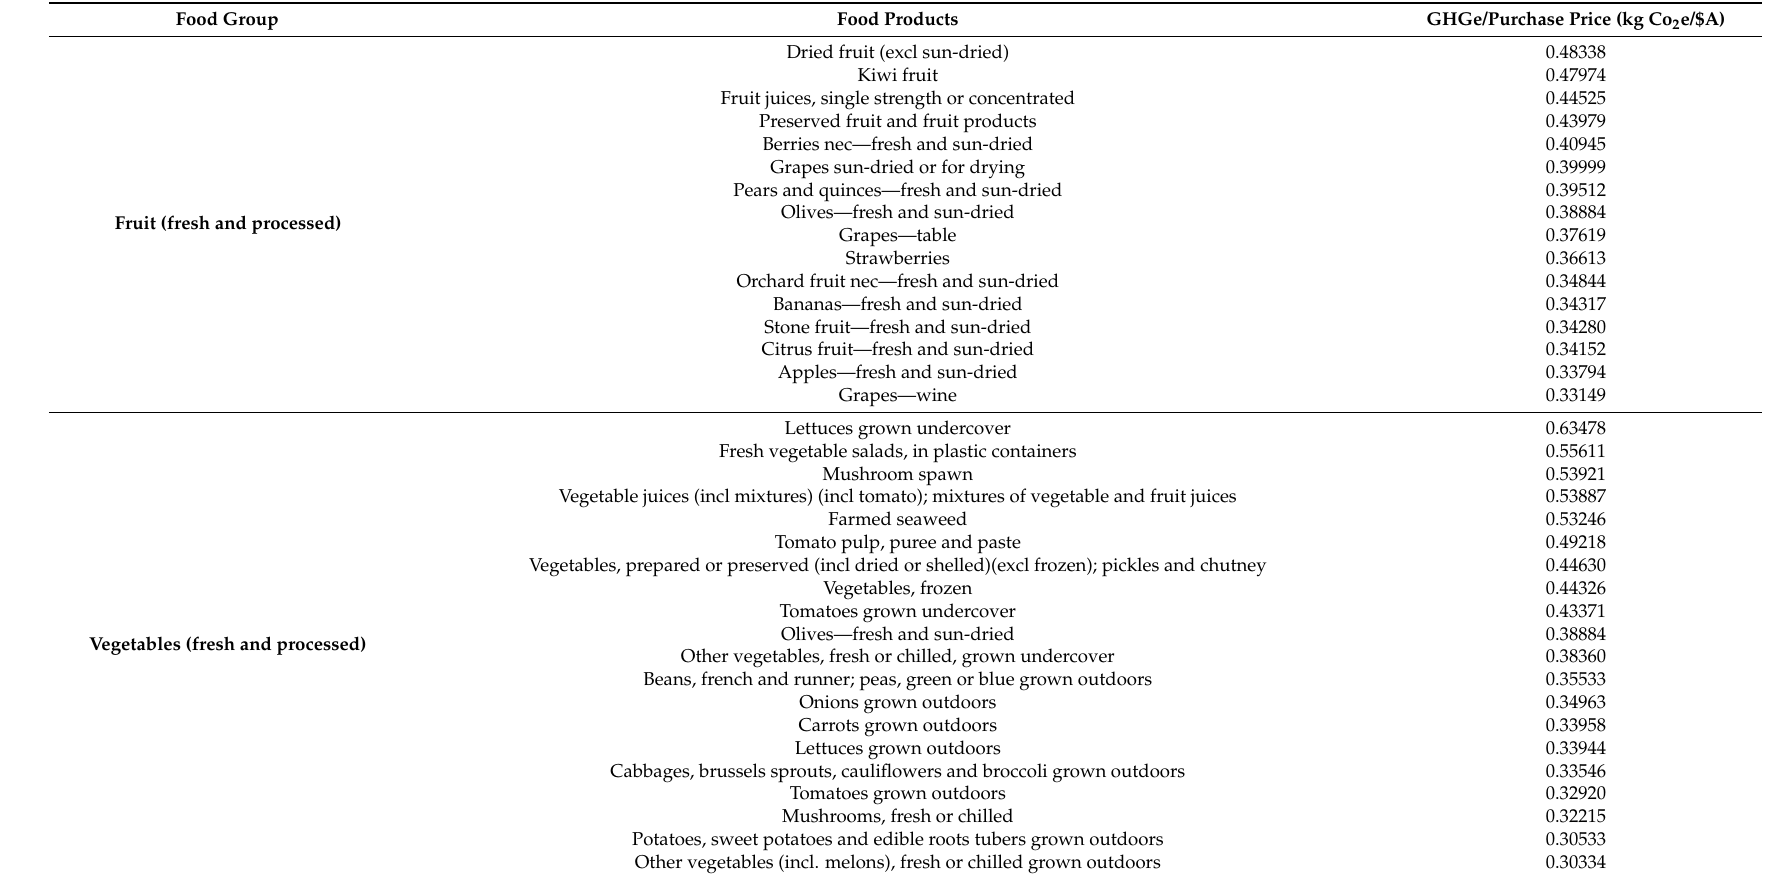
Table A1. Greenhouse gas emissions per purchase price (kg CO 2 eper Australian dollar (($A) for all food products used in this analysis, categorized into their respective food